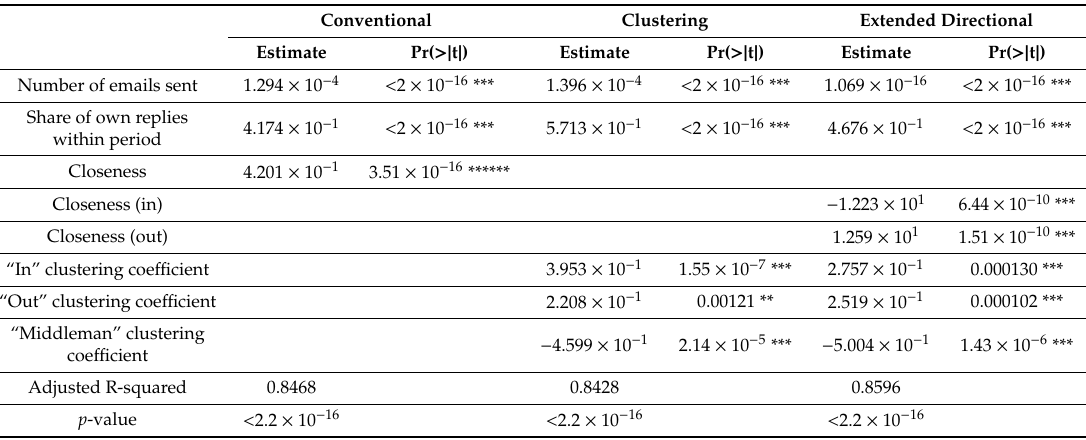
Table 7. Seven-day